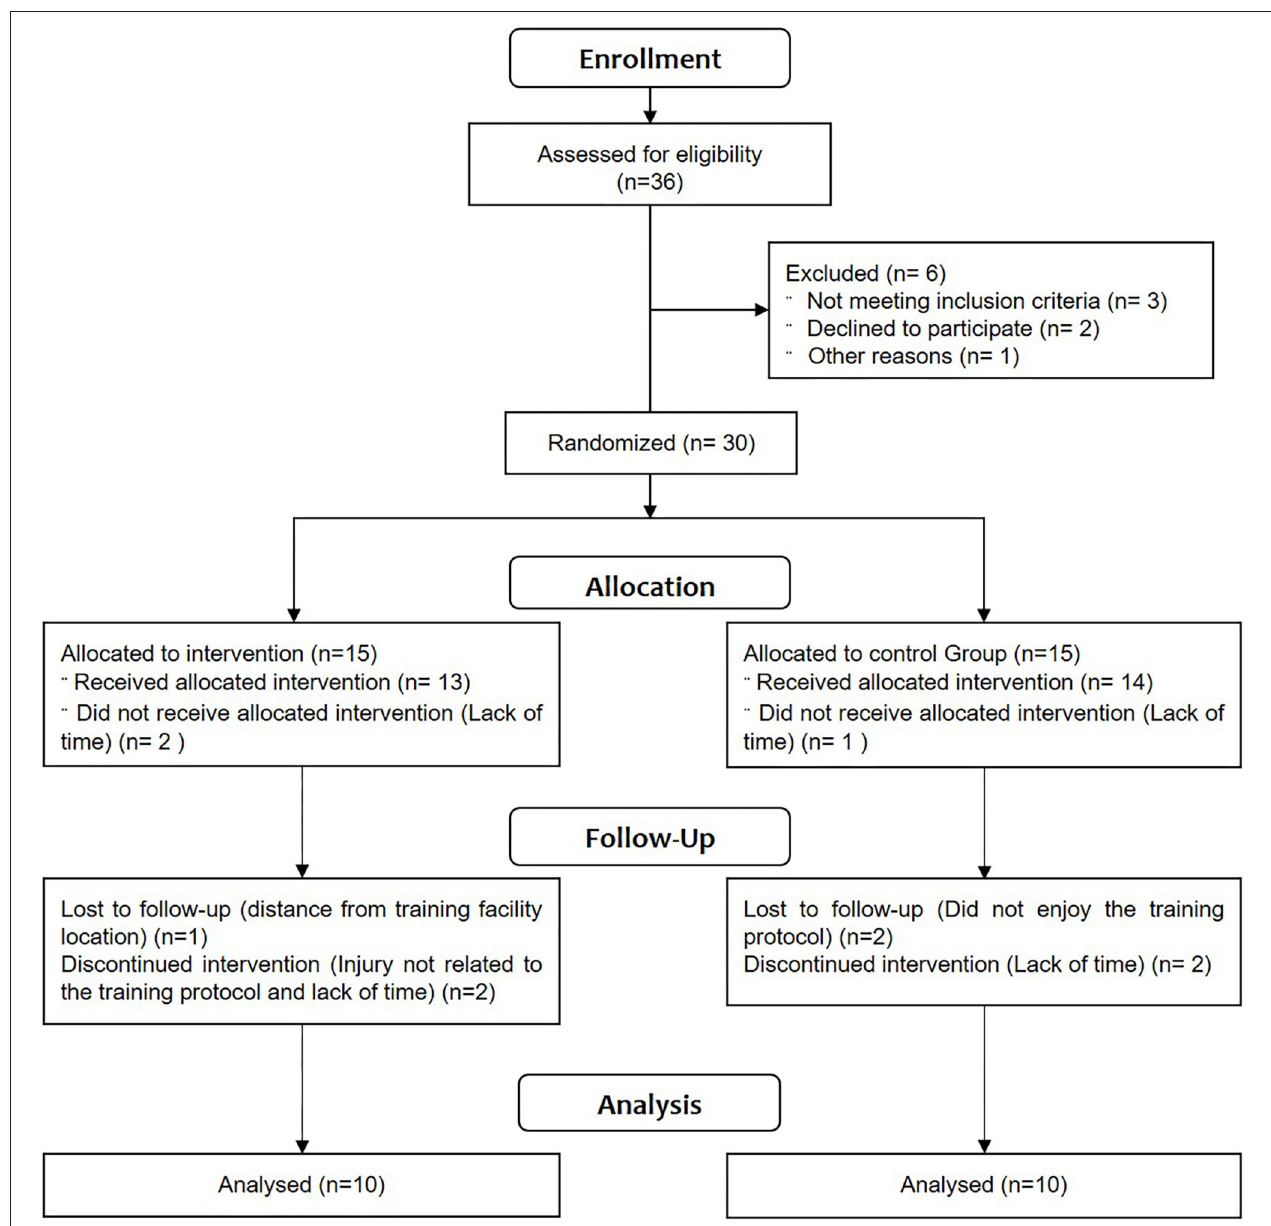
FIGURE 1 | Diagram illustrating participant flow through experimental study design.